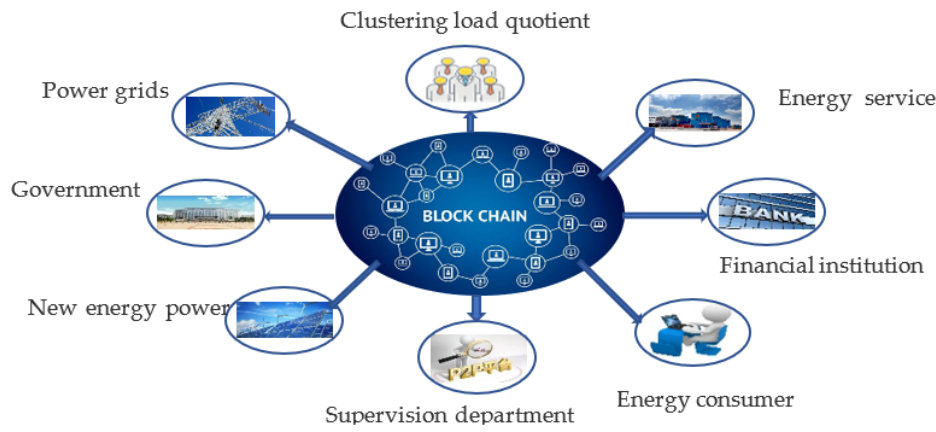
Figure 5. Application of blockchain technology in the energy market.